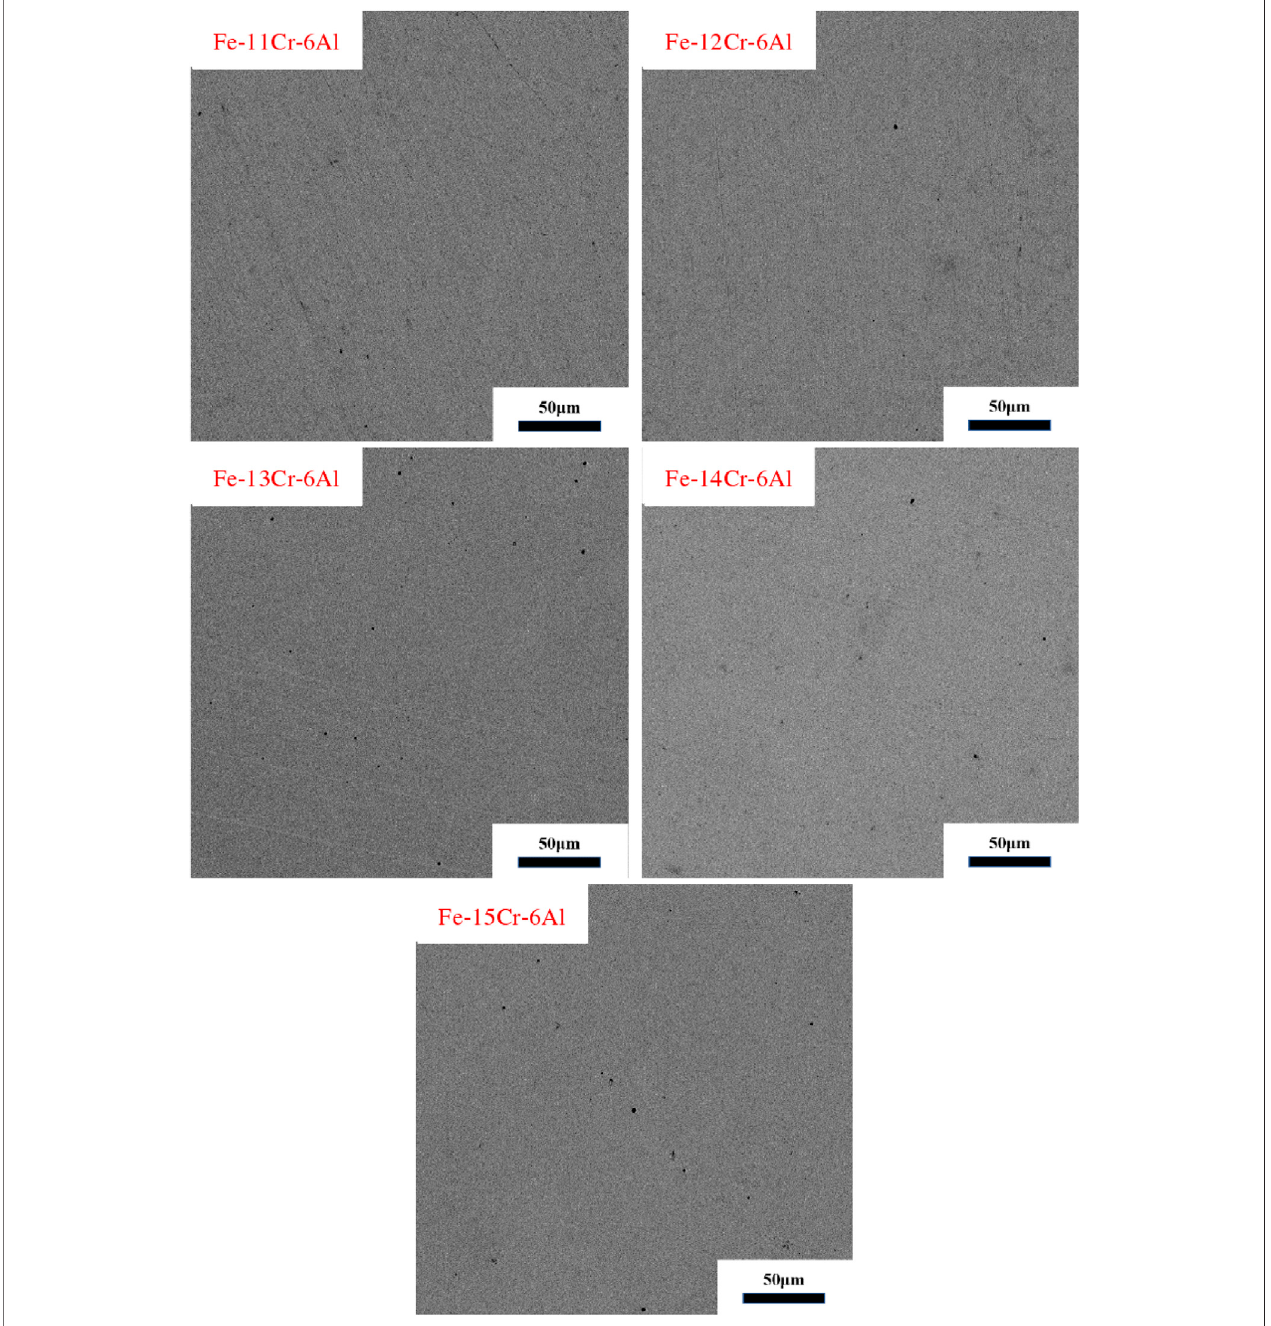
FIGURE 4 | As-cast Fe – 13Cr – 6Al alloy before metallographic surface treatment.